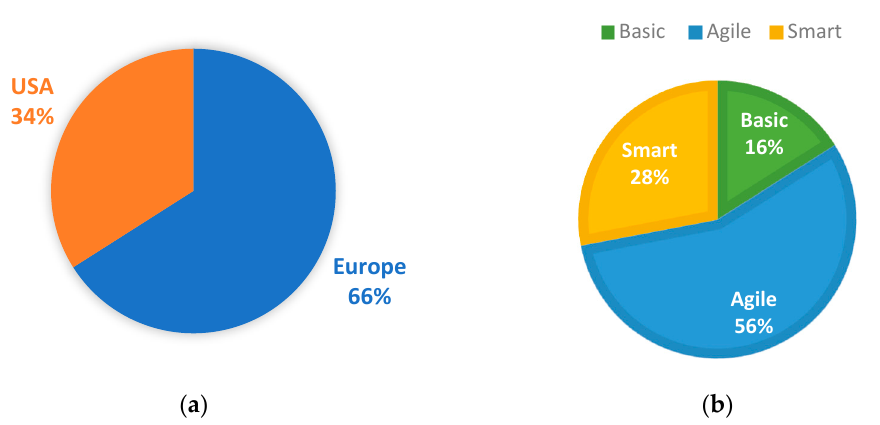
Figure 1. ( a ) Source of airports’ replies; ( b ) Airports’ classification based on IoT Figure 1. (a) Source of airports’ replies; (b) Airports’ classification based on IoT apps.